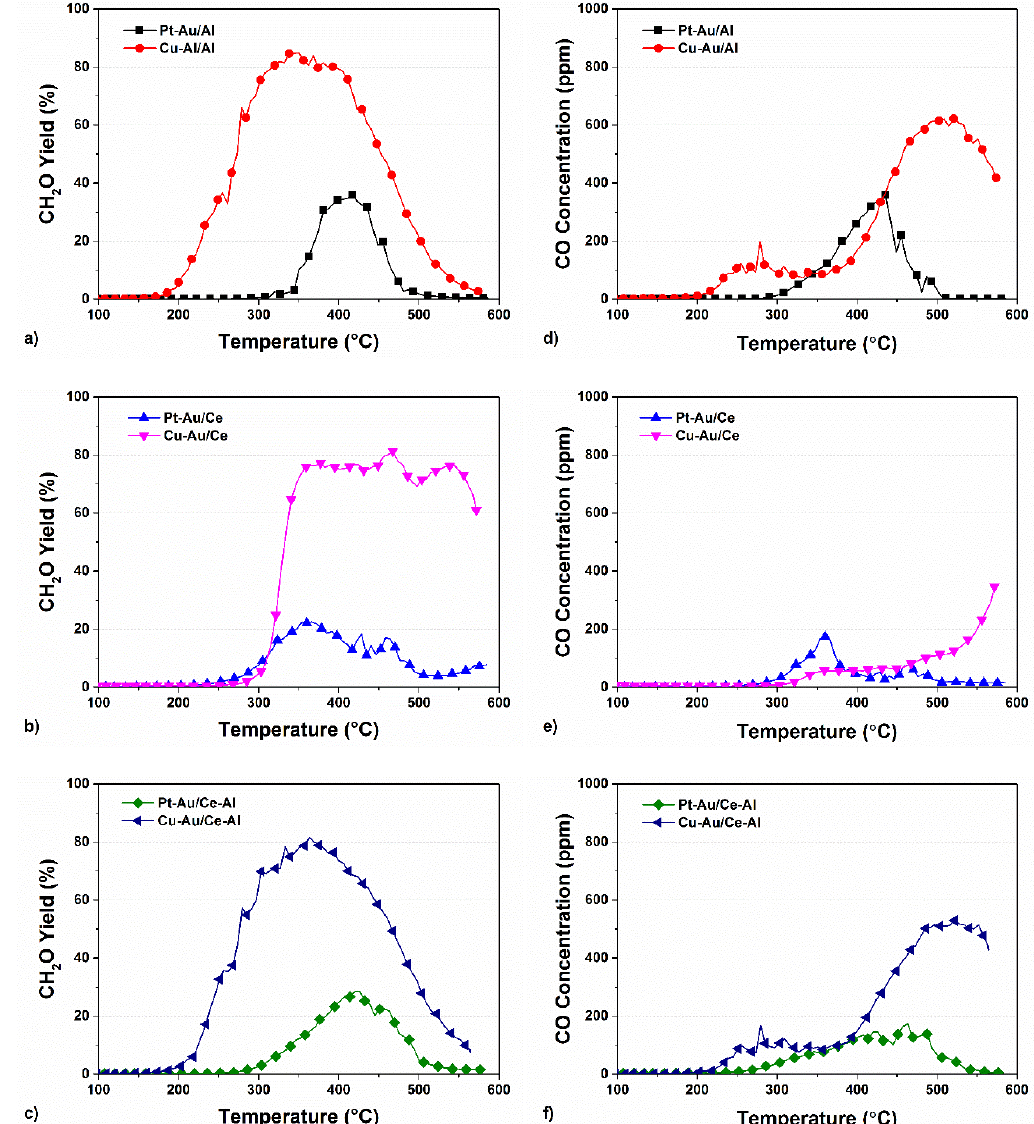
Figure 12. CH 2 O yields over the Pt – Au and Cu – Au catalysts on ( a ) γ -Al 2 O 3 , ( b ) CeO 2 , and ( c ) Pt – Au and Cu – Au on CeO 2 – Al 2 O 3 and CO concentration over the Pt – Au and Cu – Au catalysts on ( d ) γ -Al 2 O 3 , ( e ) CeO 2 , and ( f ) CeO 2 –Al 2 O 3 in the oxidation of DMDS (the same experimental conditions as in ( e ) CeO 2 , and ( f ) CeO 2 – Al 2 O 3 in the oxidation of DMDS (the same experimental conditions as in Figure Figure 9).